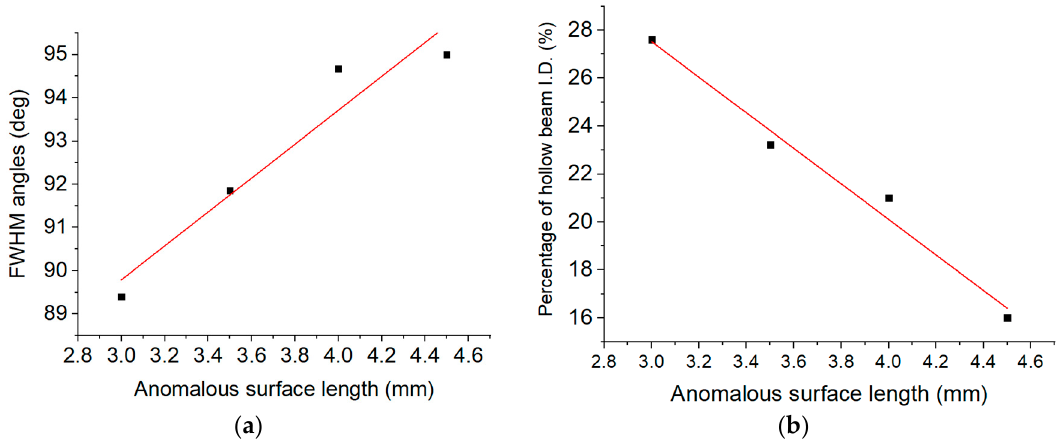
Figure 10. ( a ) Angular FWHM is plotted as a function of AS length in mm, ( b ) Central intensity-depression (dip) of hollow beam as a percentage of the maximum values and the AS length in mm. Each point in the two graphs corresponds to four tapers with similar AS lengths.